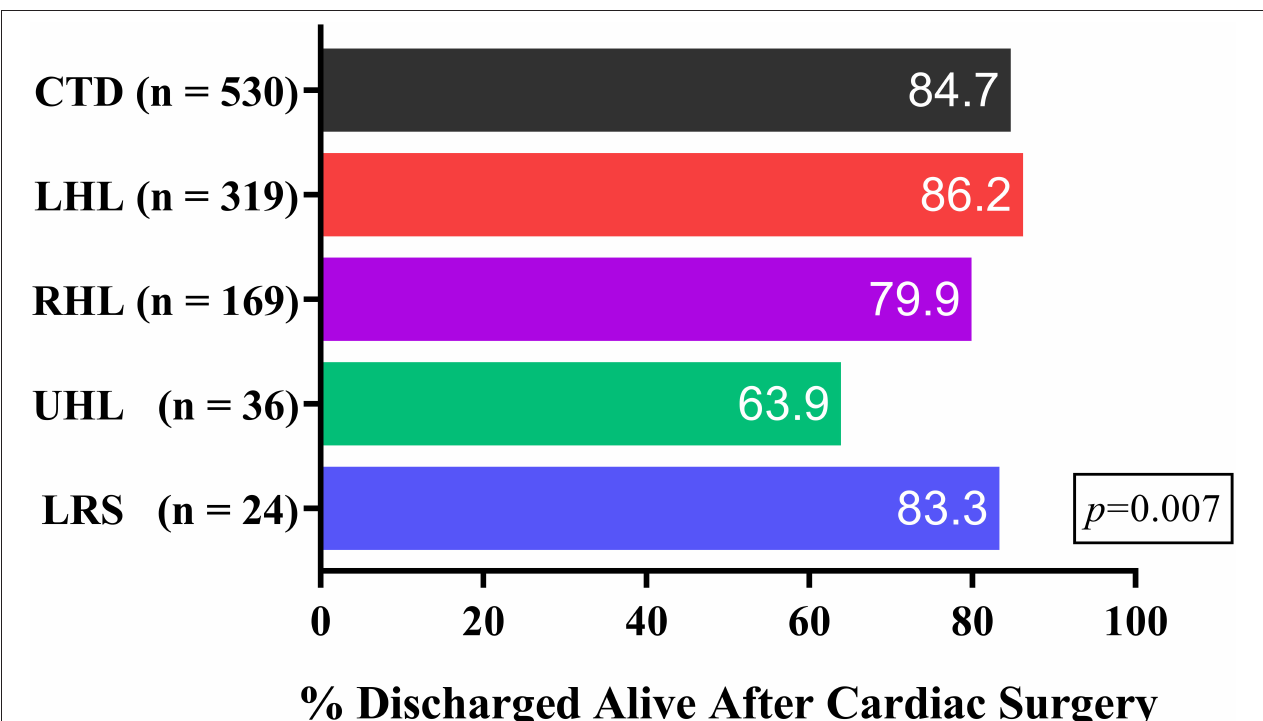
FIGURE 3 | Early survival rates in different group of primary diagnosis. CTD, conotruncal defects; LHL, left heart lesions; LRS, left to right shunt; RHL, right heart lesions; UHL, univentricular heart lesions.